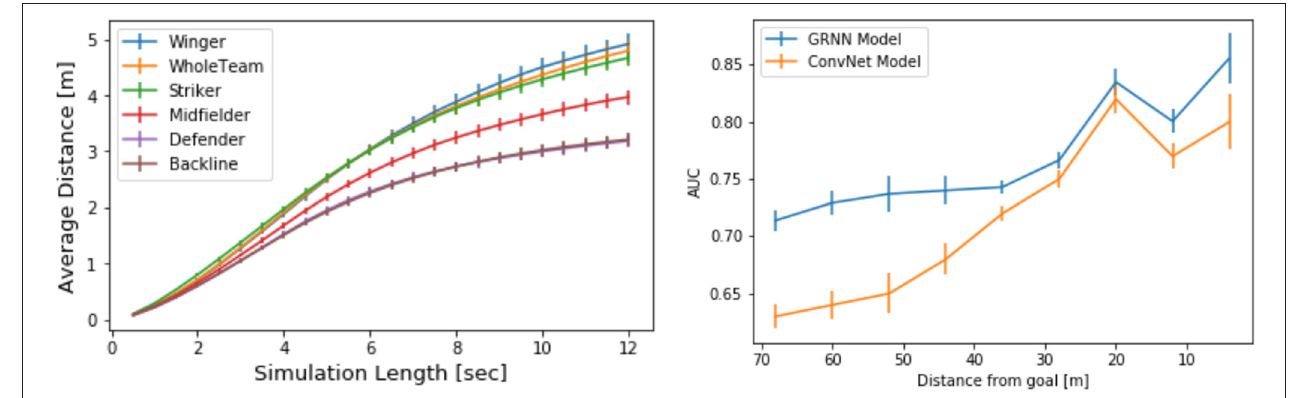
FIGURE 4 | (Left) average distance between real and simulated player trajectories. (Right) comparison of AUC values of rating baseline (Dick and Brefeld, 2019) and this model along the length of the soccer pitch.